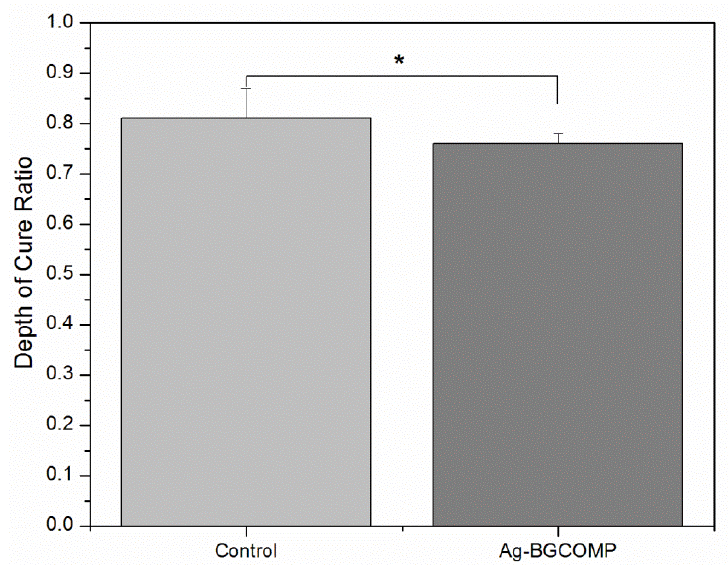
Figure 2. Depth of cure ratio mean value for control and Ag-BGCOMP. * = statistically significant difference ( p = 0.02) between the two groups. Error bars represent the standard deviation (SD) calculated in each group.